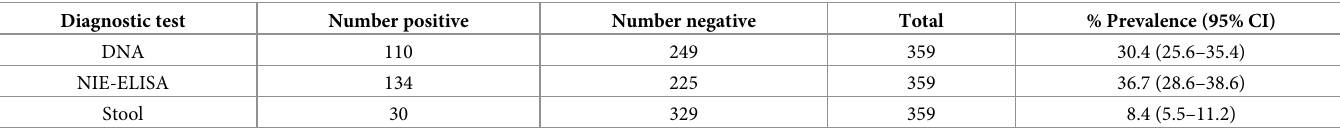
Table 3 contains the results from the Bayesian LCA model estimates (i.e. posterior medians and 95% Credible Intervals (CrI), which are the Bayesian analogs of confidence intervals) for sensitivity and specificity for each of the three diagnostic tests and the prevalence of S . stercora- lis infection for the two age groups. The S . stercoralis infection prevalence in persons < 15 years was estimated as 13.5% (95% CrI 5.9–24.8) and for age (cid:21) 15 years this was estimated to be 19.8% (95% CrI 10.7–34.2). These estimates are based on Bayesian latent class modeling of col- lective values between the three diagnostic tests having taken into account associated measure- ment error from each test, not on the results of any one single test, and thus they are more accurate than the empirically calculated prevalence in Table 2. The estimate of sensitivity for serology slightly exceeded the estimate of the diagnostic sensitivity for urine-based PCR, but their 95% corresponding credible intervals overlapped, suggesting that the diagnostic perfor- mances of these two tests were similar. Specificity of urine based-PCR was estimated to be slightly higher than that estimated for serology, but, again, the 95% credible intervals over- lapped with the corresponding estimate for serology. There was no substantial change in these results when the priors were altered by 10%. The Bayesian modeling results confirm the low sensitivity (43.6: 95% CrI: 25.7 to 70.4) and high specificity (97.9; 95% CrI: 96.5 to 98.9) of stool examination for S . stercoralis infection. Table 2. Prevalence of Strongyloidesstercoralis infection obtained by Urine-based DNA detection and NIE-ELISA serology and coprology. Diagnostic